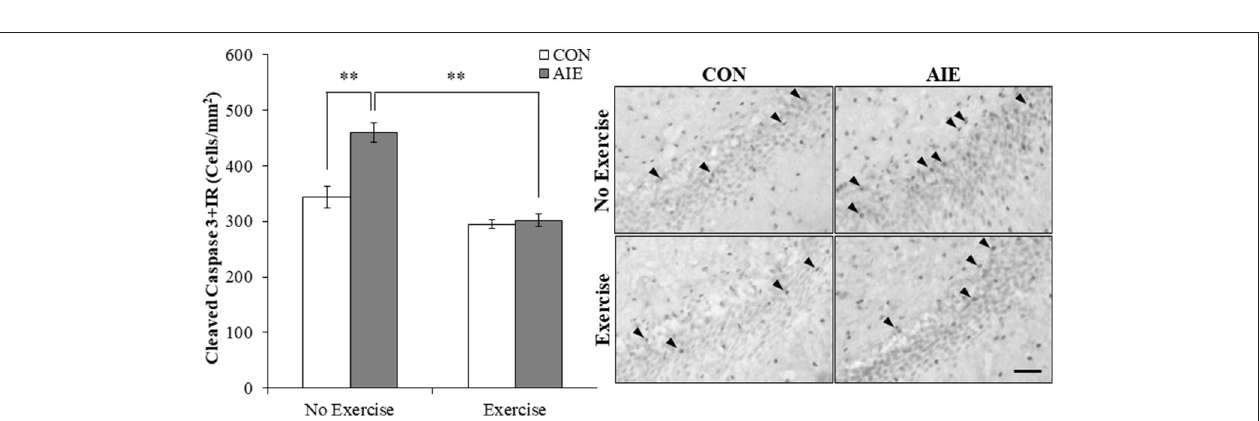
FIGURE 4 | Voluntary exercise prevented the adolescent intermittent ethanol (AIE)-induced loss of the immature neuron marker doublecortin in the adult hippocampal dentate gyrus. Pixel density quantification revealed a 36% ( ± 6%) reduction of doublecortin + IR in the adult (P80) hippocampal dentate gyrus of AIE-treated animals, relative to CONs. Subjects in the AIE treatment group that were exposed to running wheels from P24 to P80 did not evidence the observed loss of doublecortin + IR, relative to standard housed AIE animals. Representative photomicrographs of doublecortin + IR in the adult hippocampal dentate gyrus from CON- and AIE-treated animals across exercise conditions. Scale bar = 100 µ m (Insert: 100 µ m). Data are presented as mean ± SEM. * p < 0.05, ** p < 0.01.